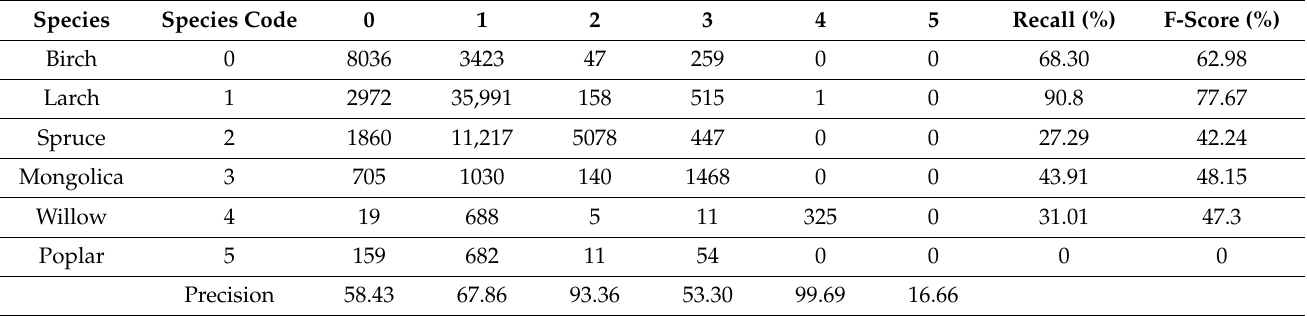
Table 5. The tree classification confusion matrix for tree species classification using ground truth (rows) compared to the CDCNN model species prediction (columns; numbered labels refer to species numbers shown in row